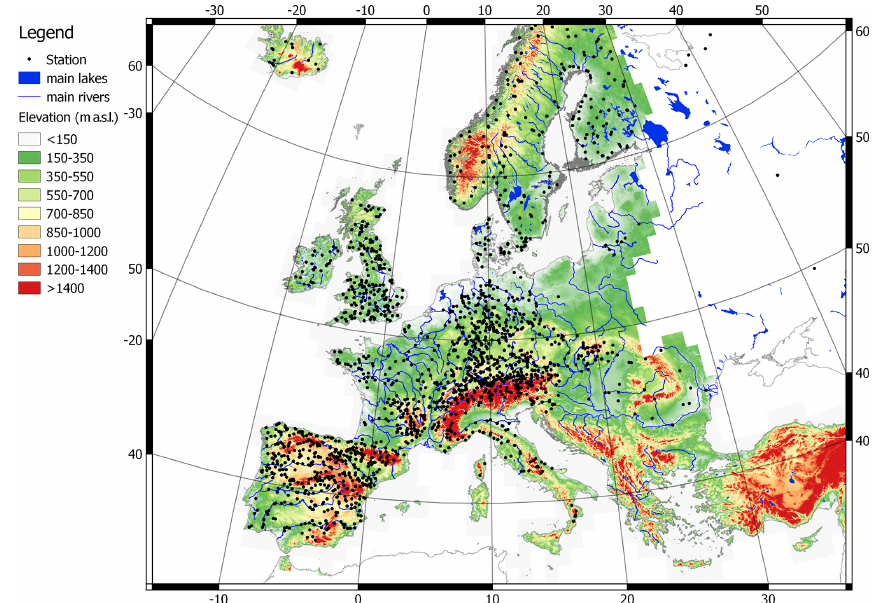
Figure 2. Map of the European study area. The digital elevation model (DEM), main rivers and lakes, as well as the position of the gauged stations are presented.